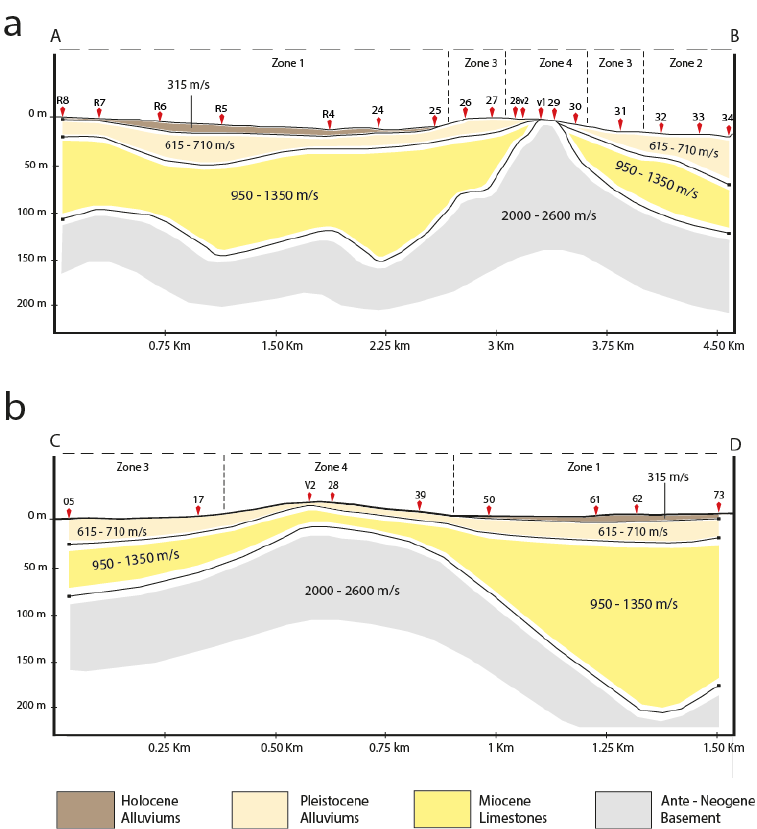
Figure 9. ( a ) Two-dimensional N-S cross-section (CD profile in Figure 3). ( b ) Two-dimensional ENE-WSW cross-section (AB profile in Figure 3). Red diamonds show the ambient noise measurement points.